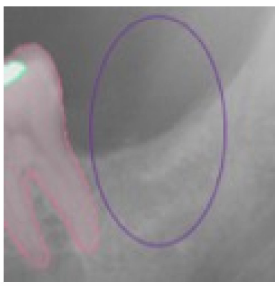
Figure 3. This selected view of Figure 1 shows the correct detection in the right position of an absent tooth in position 3.7. The assigned value was TN.